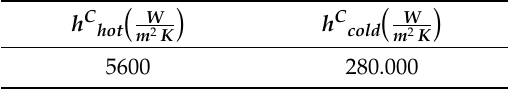
Table 2. Heat Transfer coefficients (W/m 2 K).